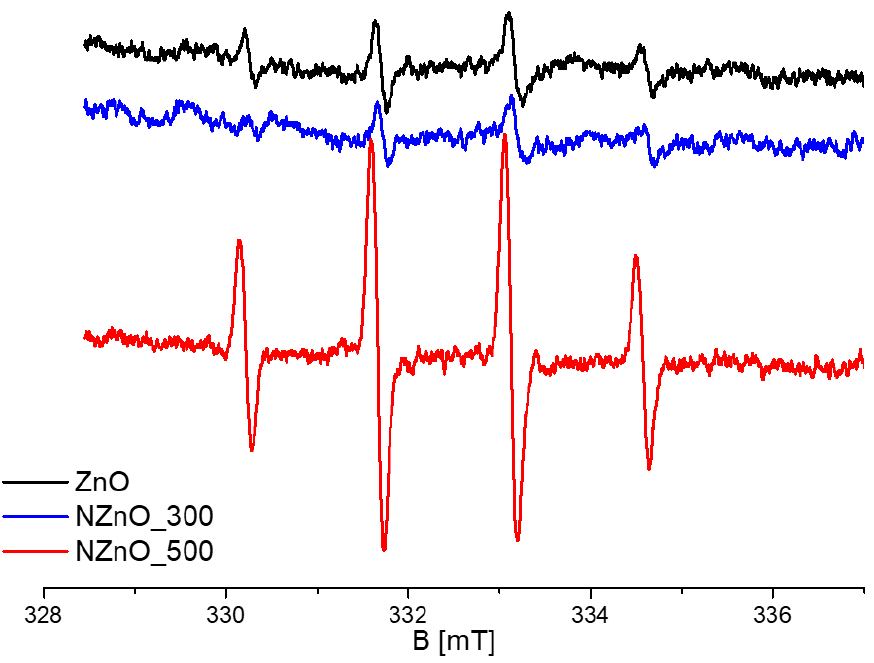
Figure 4. EPR spectra of the DMPO/OH • adduct produced by irradiation of aqueous suspensions of ZnO NZnO_300 and NZnO_500 with visible light at 610 nm. The x-axis represents the applied magnetic field (B) in units of milli-tesla (mT).